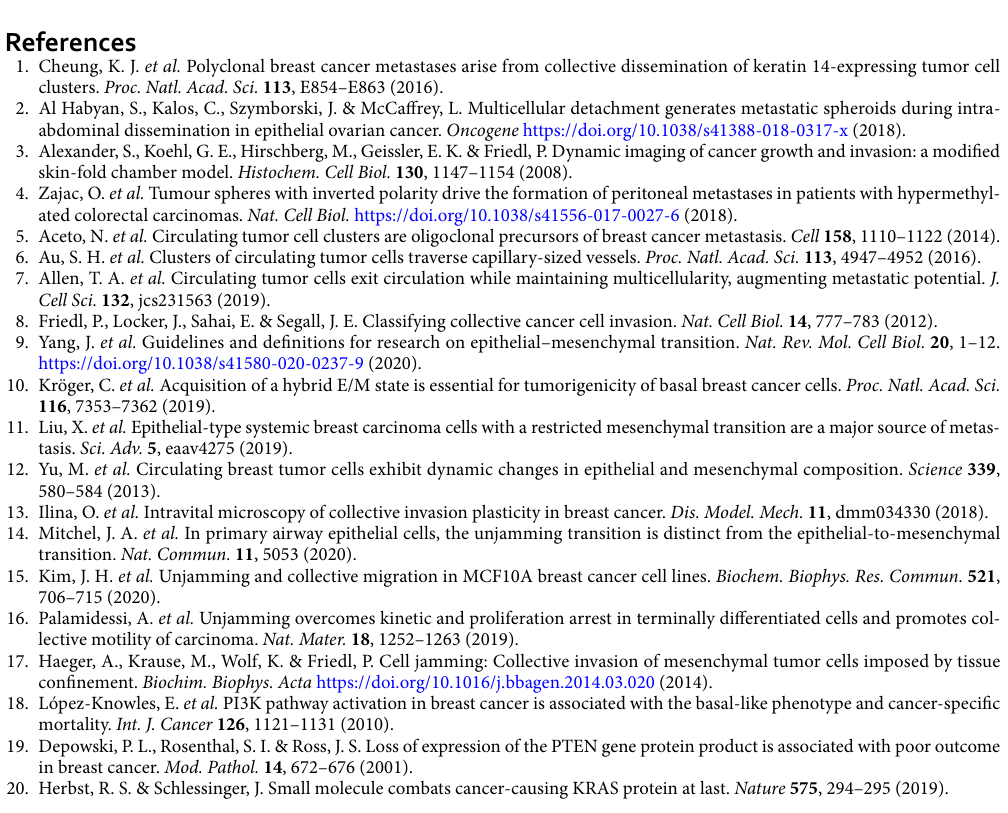
Figure source data is available in Supplementary Dataset S1. The code used for PIV and collective migration analysis is available from https:// github. com/ Scien tistR achel/ multi Scale PIVan alysis; https:// doi. org/ 10. 5281/ zenodo. 47187